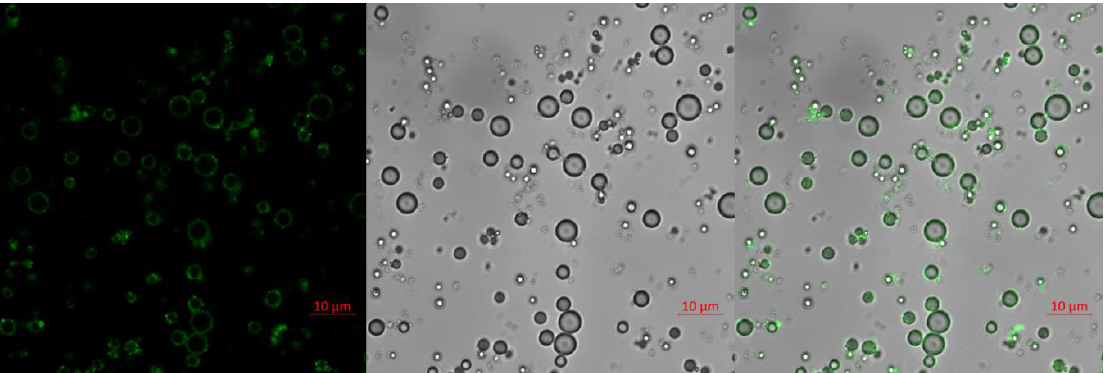
Figure 3. Confocal images of FITC-labeled IMC. Scale bar: 10 μm.